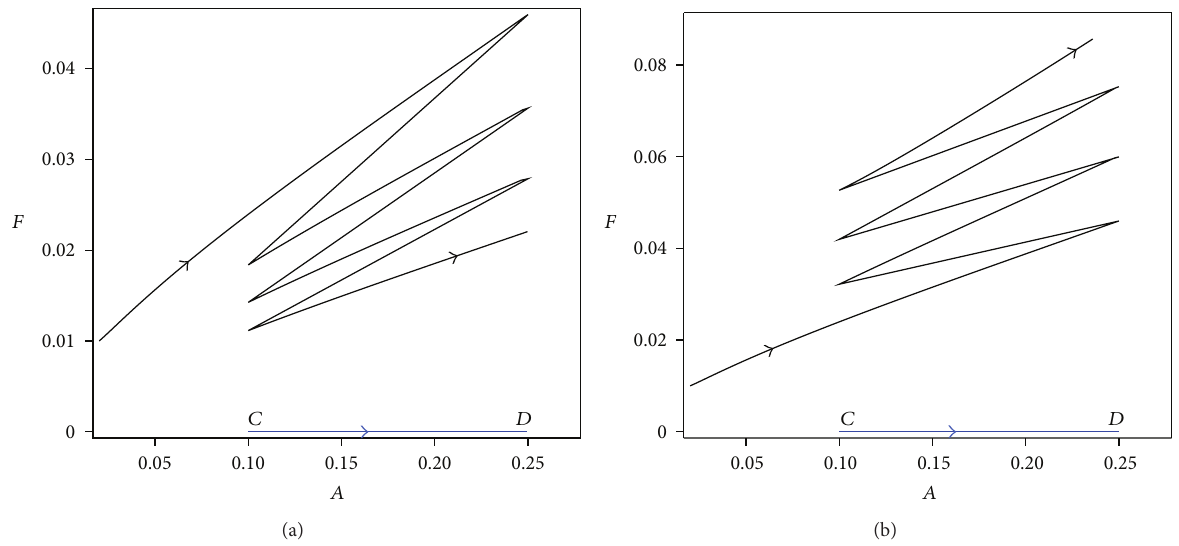
Figure 4: Trajectories with the initial point (0.02, 0.01) in system (1) where (a) 𝑞 = −0.6 and (b) 𝑞 = −0.3 , where the blue line CD displays the semitrivial of system